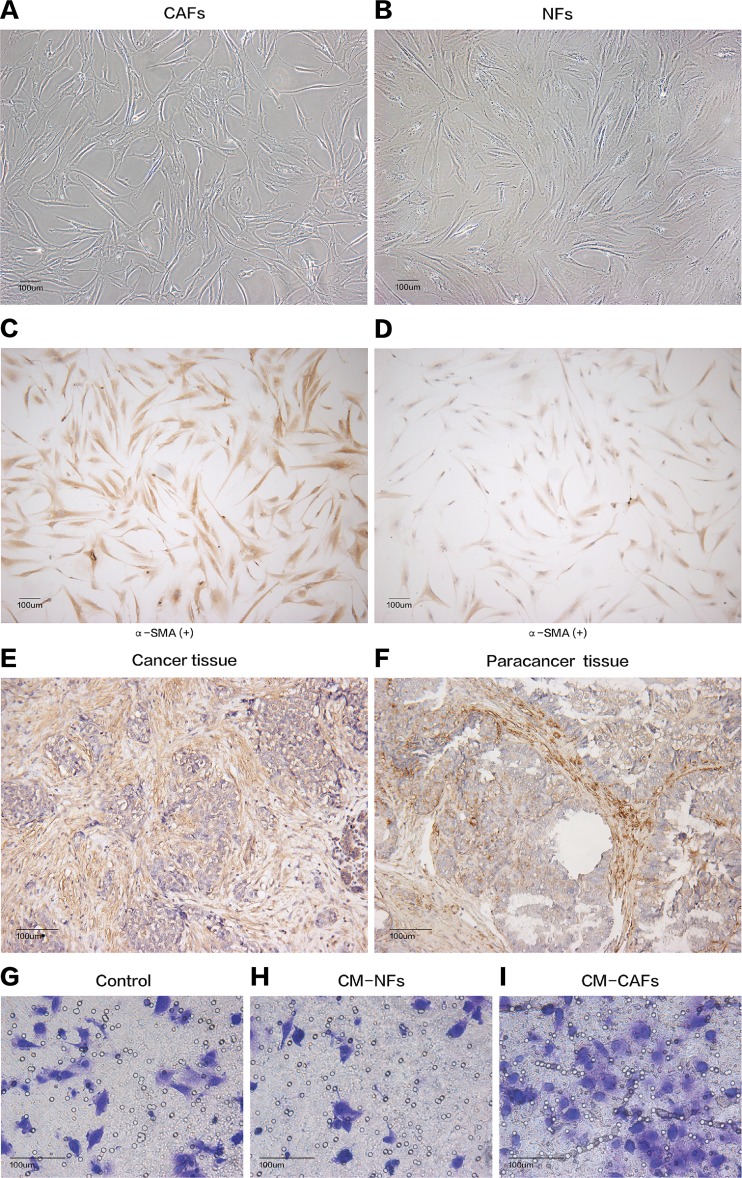
Cell morphology and α-SMA expression cannot be used to distinguish CAFs and NFs, but these fibroblasts differ in their biological functions.(A and B) CAFs and NFs are both morphologically characterized as large spindle-shaped cells with indented nuclei. Bar: 100 μm. (C and D) Immunohistochemical staining for α-SMA in CAFs and NFs. Both samples are positive for α-SMA expression. Bar: 100 μm. (E and F) Immunohistochemical staining for α-SMA in a cancer tissue and a paracancerous tissue more than 3 cm away from carcinoma. Bar: 100 μm. (G–I) Invasion of MCF-7 cells was affected by CM. Bar: 100 μm.